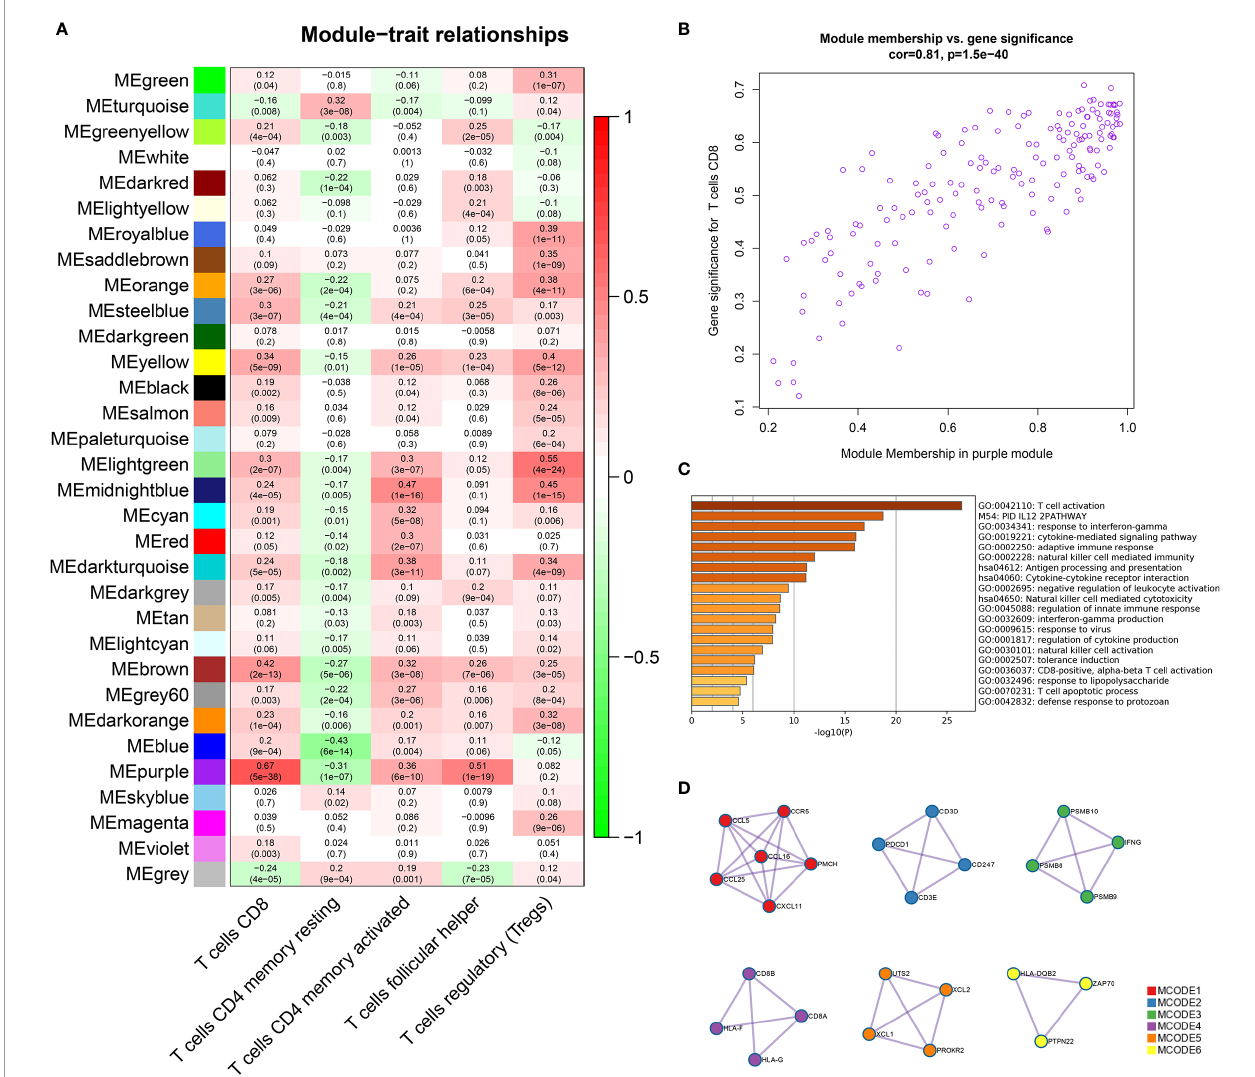
FIGURE 1 | Identi fi cation of important modules related to T cells through WGCNA. (A) The correlation between the modules and the fi ve T-cell subtypes. The scale bar indicated the range of the correlation coef fi cient, and the p value is in the parentheses. (B) Correlation between purple module members and gene signi fi cance. (C) GO and KEGG enrichment analysis of 169 genes in the purple module con fi rmed that these genes were mainly enriched in the process of T-cell activation and antigen processing and presentation. (D) Six tightly linked networks in the purple module were obtained using the MCODE